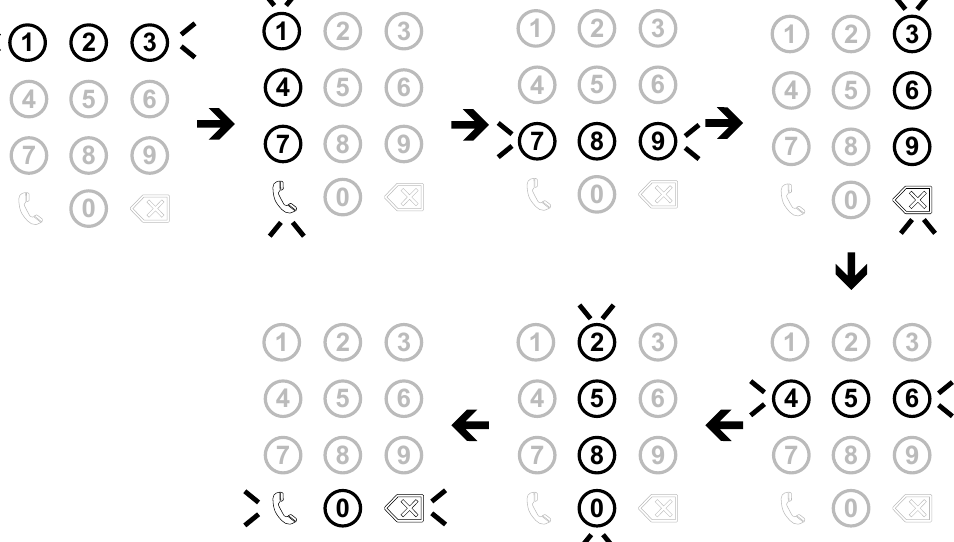
Figure 7. Stimuli in the telephone-call brain–computer interface. According to the order indicated by the arrows, each row and line